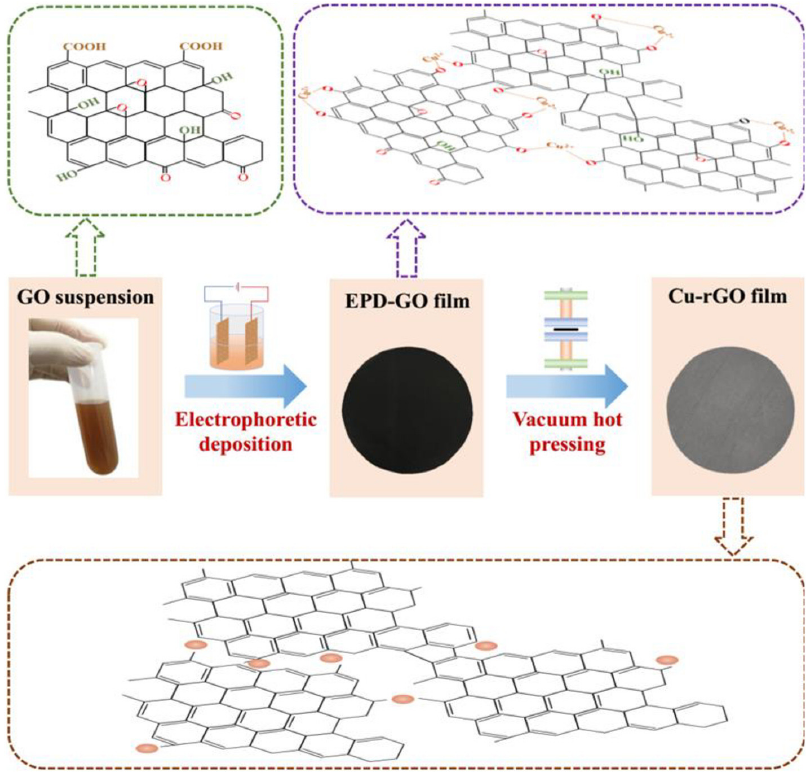
Figure 5. Schematic depicts the preparation process of composite film. Reprinted with permission from ref. [61] Copyright 2020, Elsevier.